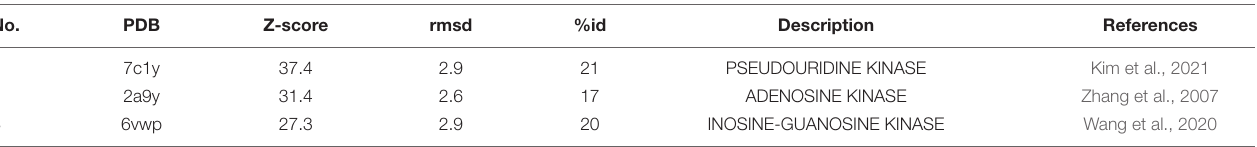
FIGURE 4 | Structure comparisons between Ec PsuK and At PUKI. (A) Structure superposition of the Ec PsuK- (cid:57) complex with the At PUKI-ADP- (cid:57) complex (PDB code: 7C1Y). The nucleoside-binding loop, ATP-binding loop, and ADP in At PUKI are all indicated by arrows. (B) Comparisons of the substrate-binding pocket between Ec PsuK and At PUKI. The nucleoside-binding loop containing T26 (cid:48) is colored green. The residues involved in substrate recognition are shown as stick. The black-colored loop is the corresponding nucleoside-binding loop in Ec PsuK, and the residue S30’ is colored in black and shown as stick. (C) Detailed comparisons of the ATP-binding site between Ec PsuK and At PUKI. The residues used for binding ADP in At PUKI, and the corresponding residues in Ec PsuK are all shown as stick. TABLE 2 | Information of the Ec PsuK homolog